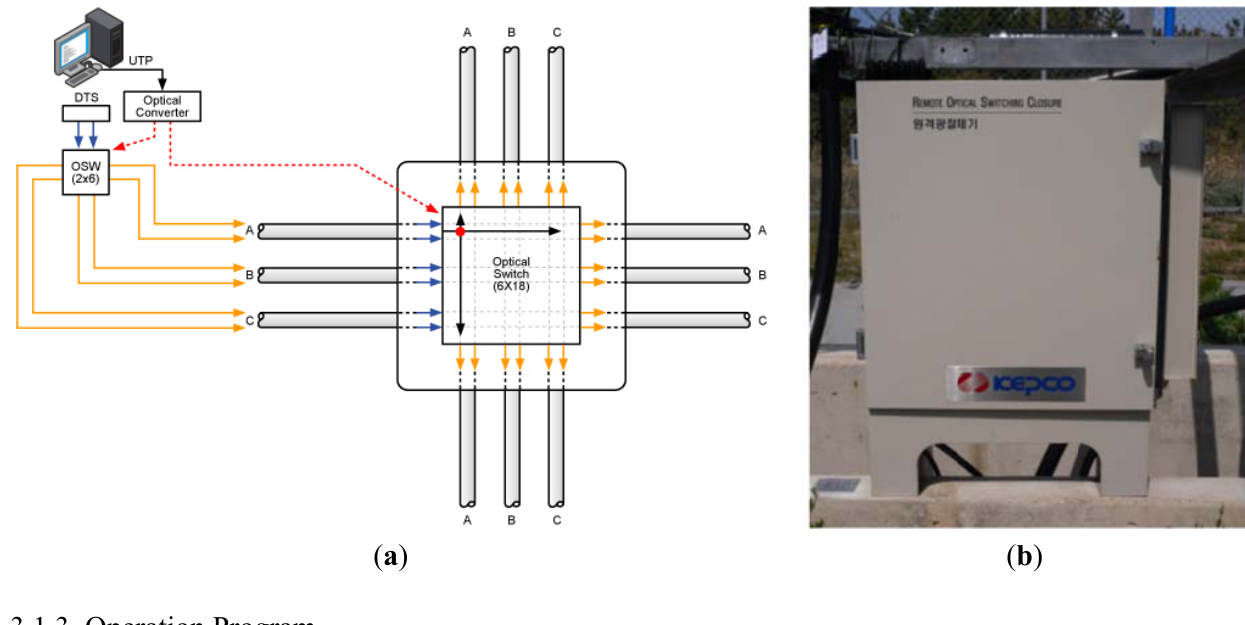
Figure 5. Optical switch: ( a ) design and ( b )